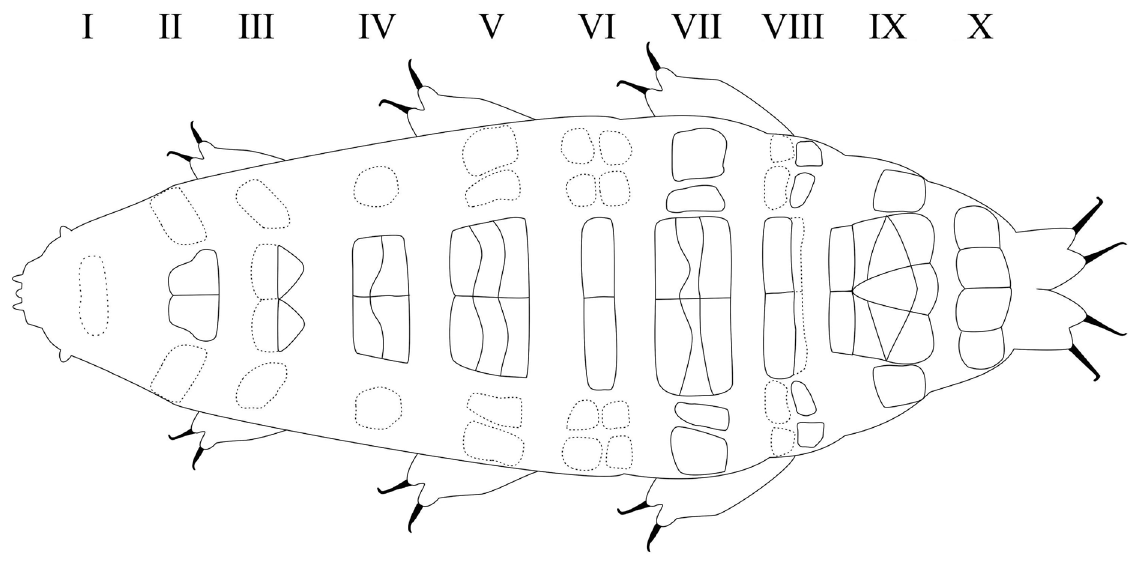
Fig. 10. Semi-schematic drawing of pseudoplate configuration in the senior specimens of Milnesium pelufforum sp.